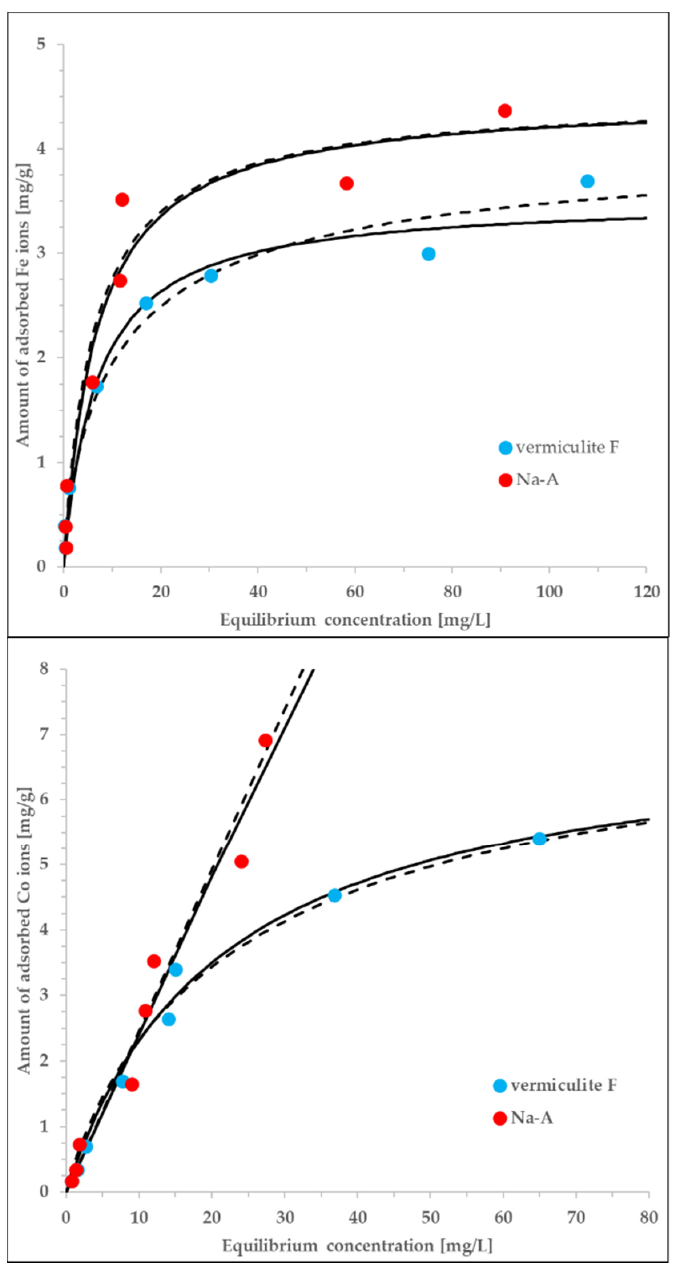
Figure 5. The experimental data measured for vermiculite F (C) and Na-A (J) interacting with either Co or Fe ions., equlibrium data correlated by both the Langmuir (solid lines) and Langmuir-Freundlich (dashed lines) equations. The adjusted exponents of the LF equation vary from 0.72 to 1.23, i.e., are close to unity. The parameters of the Langmuir model are discussed in the text. The rest of the details is given in the main text.